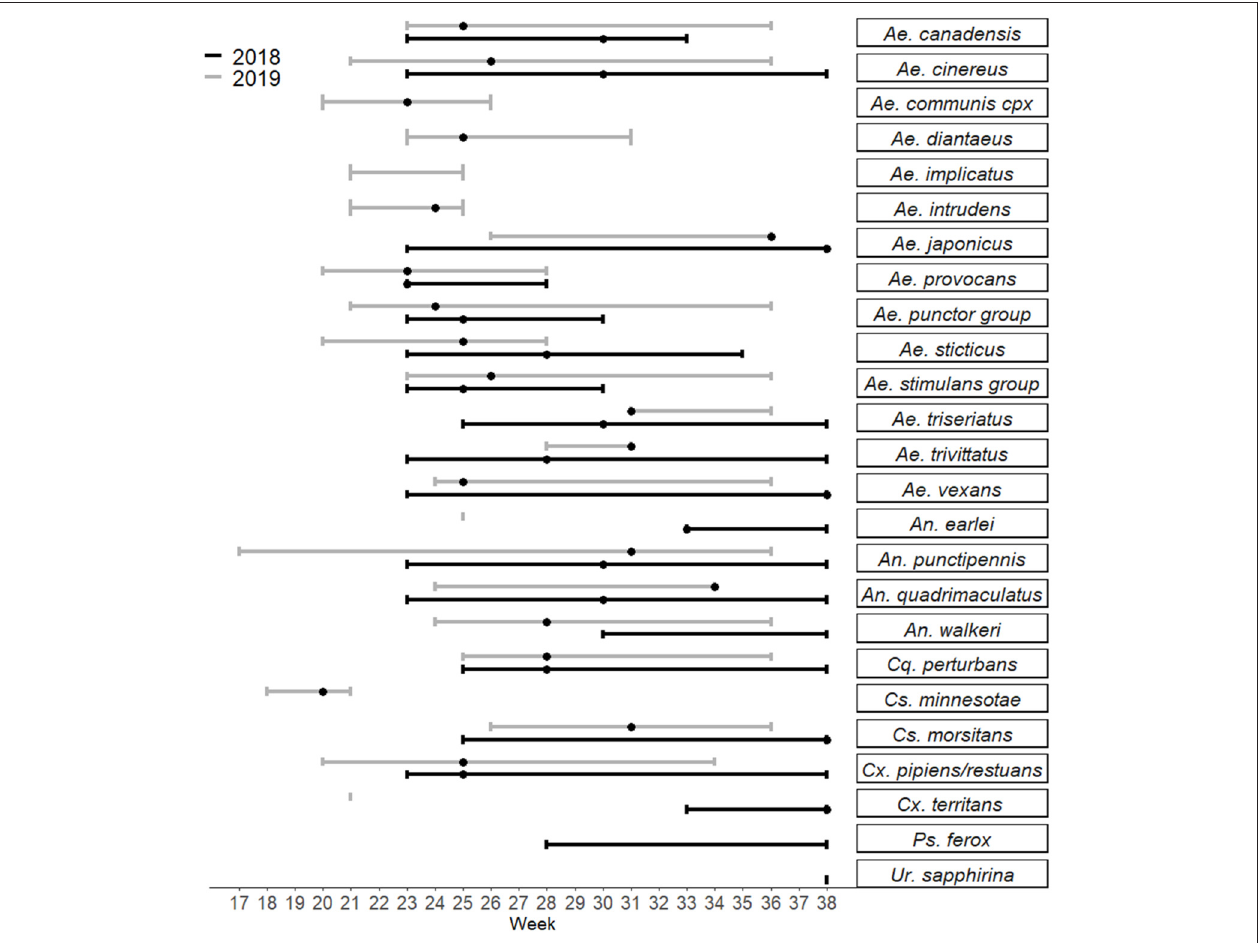
FIGURE 1 | Seasonality of adult female mosquitoes trapped from 2018 to 2019 in Sawyer and Washburn Counties near Hayward, WI. Bars represent the range of weeks during which specimens were collected, and dots represent the week during which the species was most abundant in that time frame. Created in R using the package ggplot2 (25,